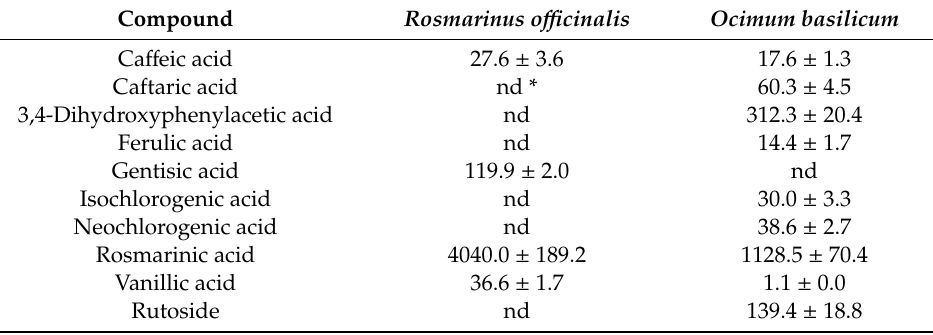
Table 1. The contents of polyphenols in R. o ffi cinalis and O. basilicum leaf extracts (mg / 100g DW ± SD).